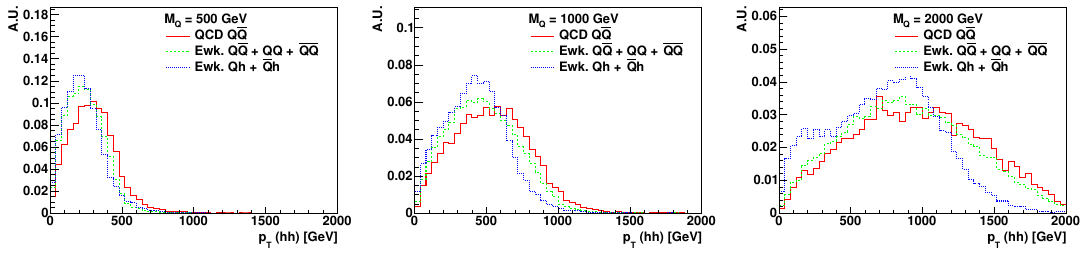
Figure 8 . Normalised distribution, at the NLO accuracy in QCD, in the di-Higgs invariant mass in the context of VLQ-induced di-Higgs production. We distinguish QCD-induced (red) and EW- induced (green) VLQ-pair production (followed by to Q ! hq decays) and the associated production of a single VLQ together with a Higgs boson (blue). We set the VLQ mass to 500 GeV (left panel), 1000 GeV (middle panel) and 2000 GeV (right panel).